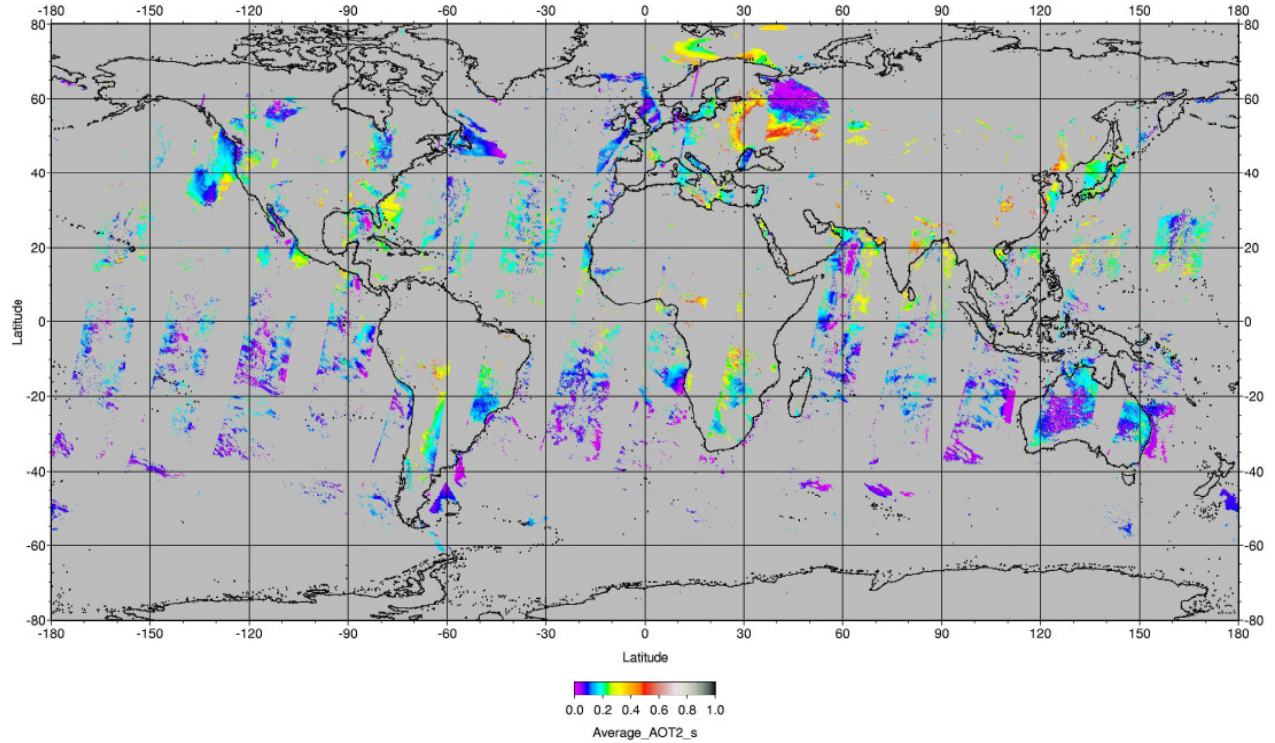
Fig. 21. Daily AOT product for the globe of 3 May 2006, obtained by BAER, using SeaWiFS GAC data for the generation of monthly